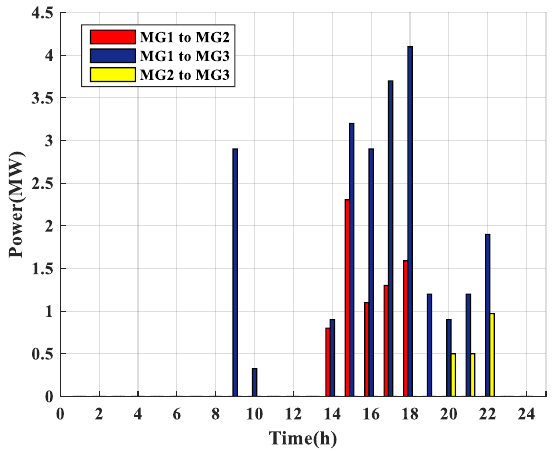
Figure 6. Amount of exchanged power among MGs.